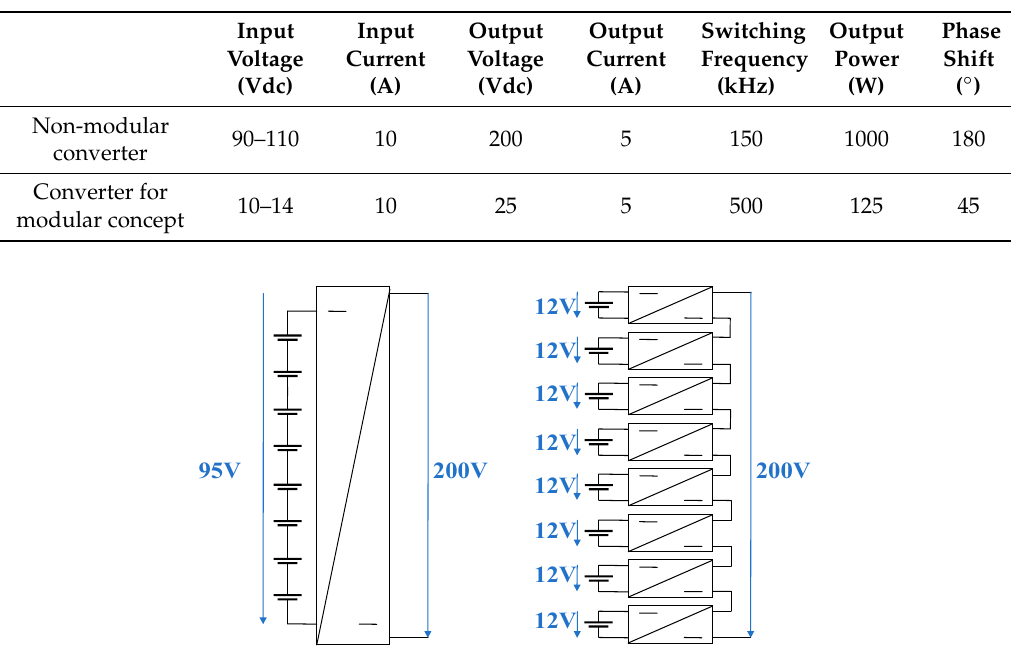
Table 4. Operational parameters of bi-BB converters in a modular and non-modular concept valid for laboratory verifications.